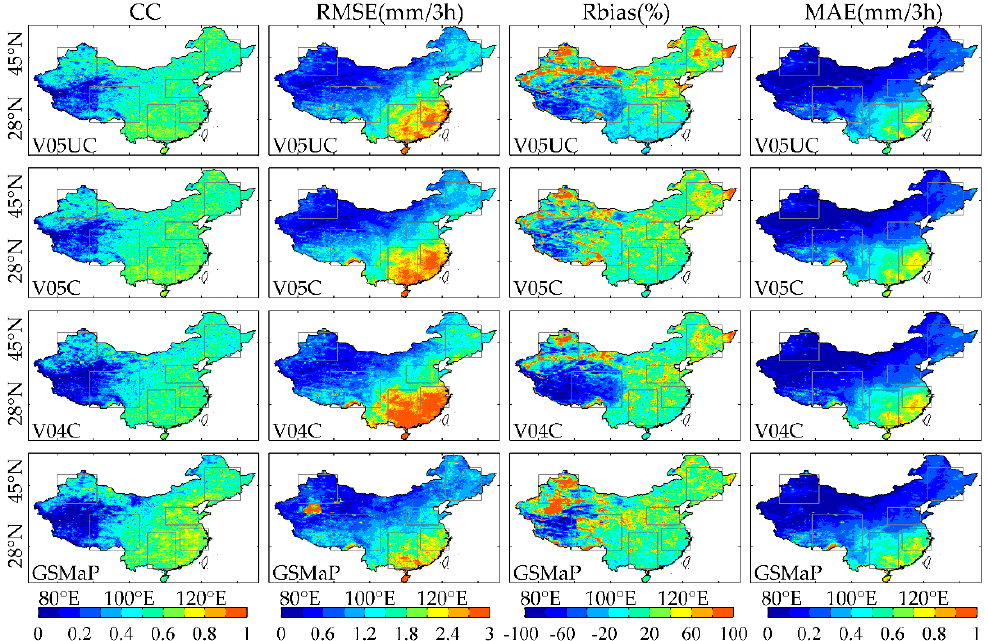
Figure 5. Spatial distributions of continuous statistical indices for the chosen four GSPEs at a 3-h time-scale and 0.1° × 0.1° resolution over mainland China: the rows from first to last represent CC RMSE (mm/3 h), Rbias (%), and MAE (mm/3 h), respectively.